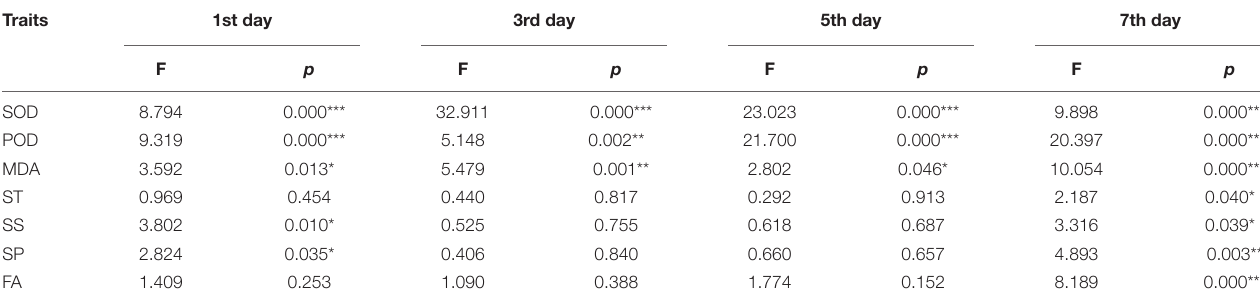
TABLE 1 | Result ( F and p- values) of one-way ANOVAs about the priming with melatonin effects on Suaeda corniculata seed antioxidant enzymes activity and reserve traits. Traits 1st day 3rd day 5th day 7th day